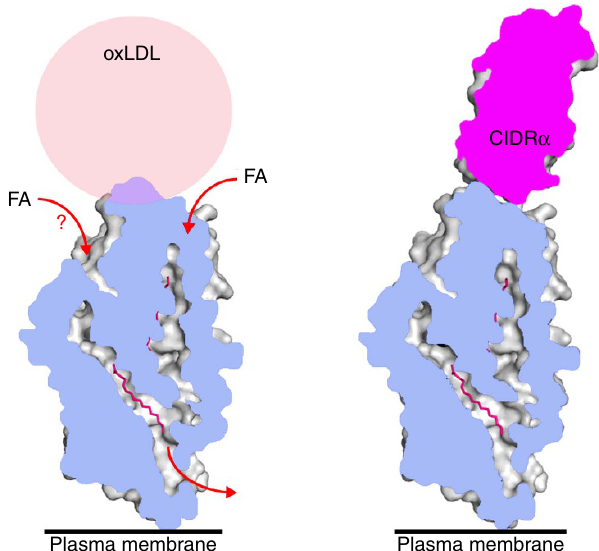
Figure 7 | A model for the inhibition of oxLDL binding by PfEMP1. One of the physiological roles of CD36 is to interact with oxidized LDL (oxLDL). Fatty acids can be incorporated from oxLDL particles, or other transport systems and pass through the central cavity of CD36 to the membrane. The PfEMP1 CIDR a 2-6 domains interact with the same surface of CD36 as oxLDL and compete for